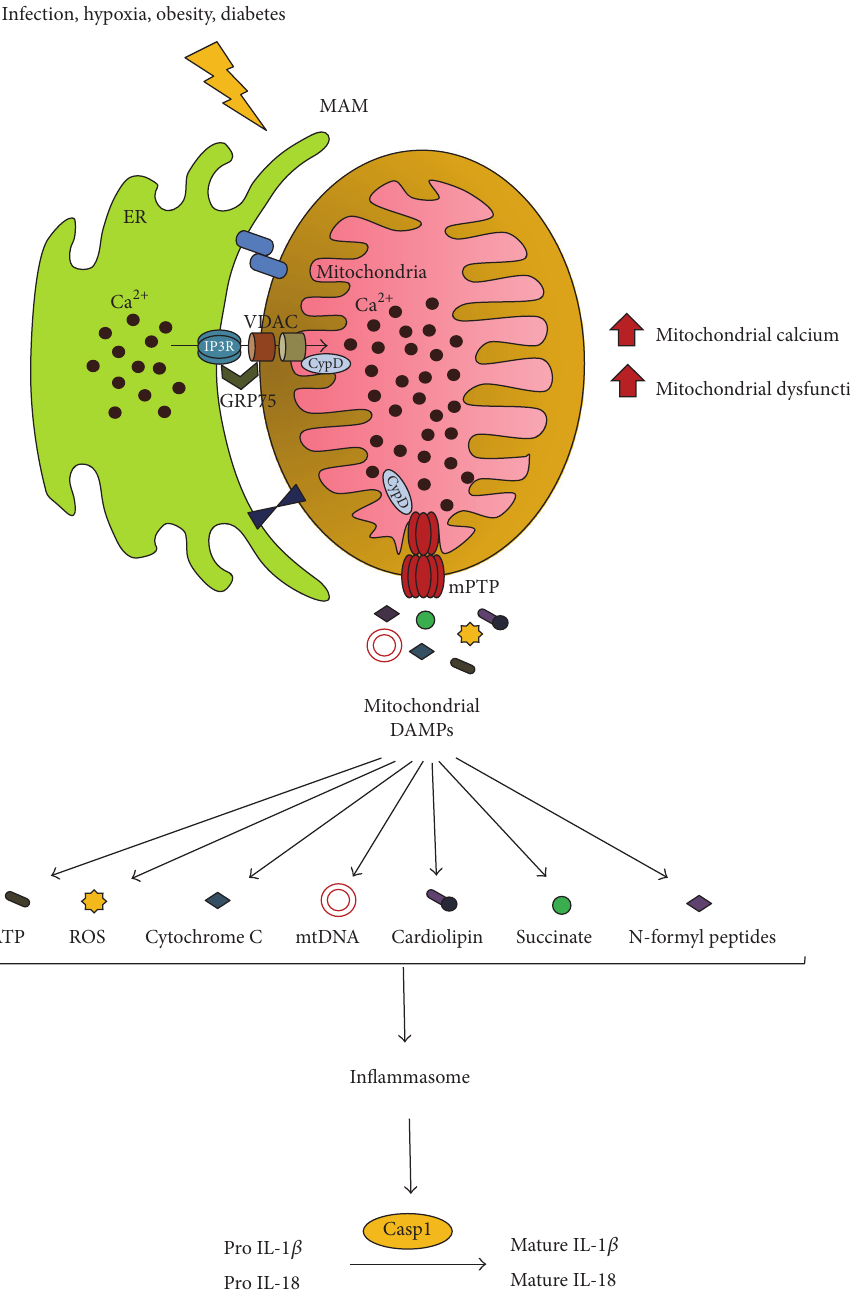
Figure 3: A hypothetical model of mitochondrial DAMP induction through mitochondria-associated ER membrane (MAM). Cellular metabolic dysfunction mediated by infection, hypoxia, obesity, and diabetes triggers abnormal association of endoplasmic reticulum (ER) and mitochondria. This increase in MAM formation induces mitochondrial calcium overload and exacerbates mitochondrial ROS generation, leading to mitochondrial permeability transition pore (mPTP) opening. The mitochondrial matrix protein CypD mediates mitochondrial calcium accumulation by physically interacting with the IP3R, GRP75, and VDAC complex at the MAM interface and modulates mPTP pore opening directly. mPTP opening facilitates release of mitochondrial components such as ATP, ROS, cytochrome C, mtDNA, cardiolipin, succinate, and N-formyl peptides into the cytosol, where they serve as mtDAMPS to activate the inflammasome. Subsequently, inflammasomes activate caspase-1 (Casp1) to induce cleavage and maturation of the proinflammatory cytokines IL-1 𝛽 and IL- 18. CypD: cyclophilin D; IP3R: inositol 1,4,5-trisphosphate receptor; GRP75: 75 kDa glucose-regulated protein; VDAC: voltage-dependent anion channel; mtDNA: mitochondrial DNA; IL-1 𝛽 : interleukin-1 beta; IL-18: interleukin-18; ATP: adenosine triphosphate; ROS: reactive oxygen species; mtDAMPs: mitochondrial damage-associated molecular